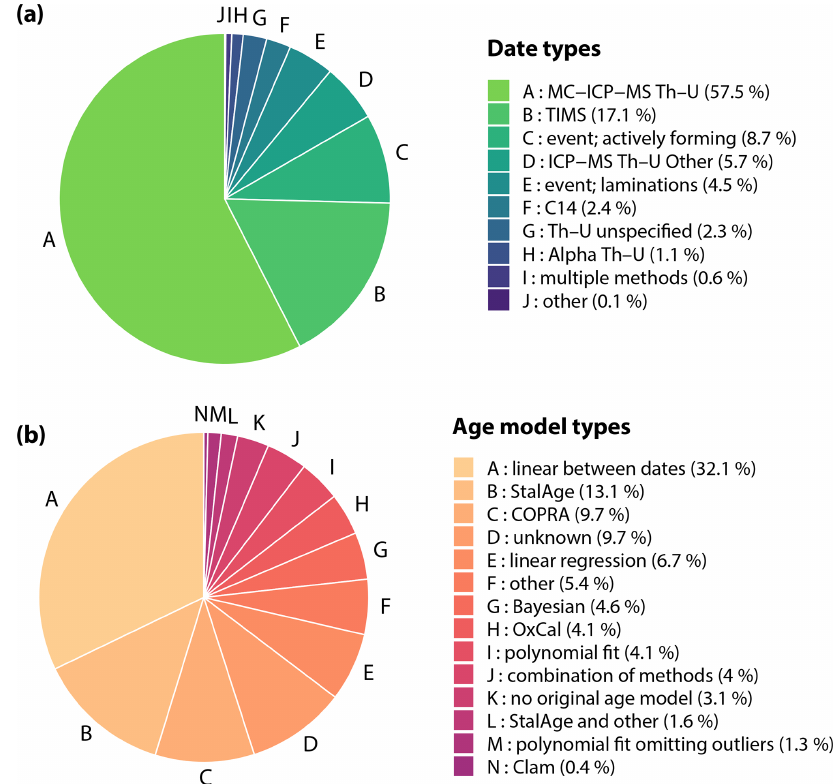
Figure 1. Summary of the dating information on which the original age–depth models are based (a) and the original age–depth model types (b) present in SISALv2.